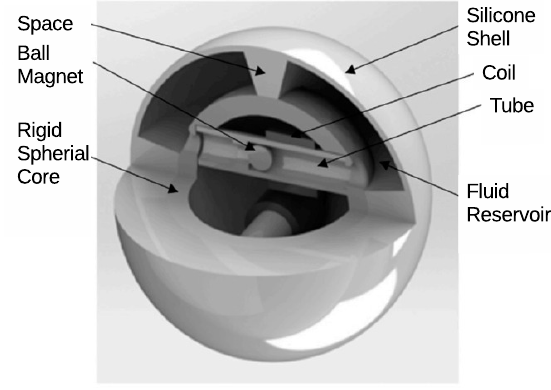
Figure 8. Image showing the harvester’s internal structure